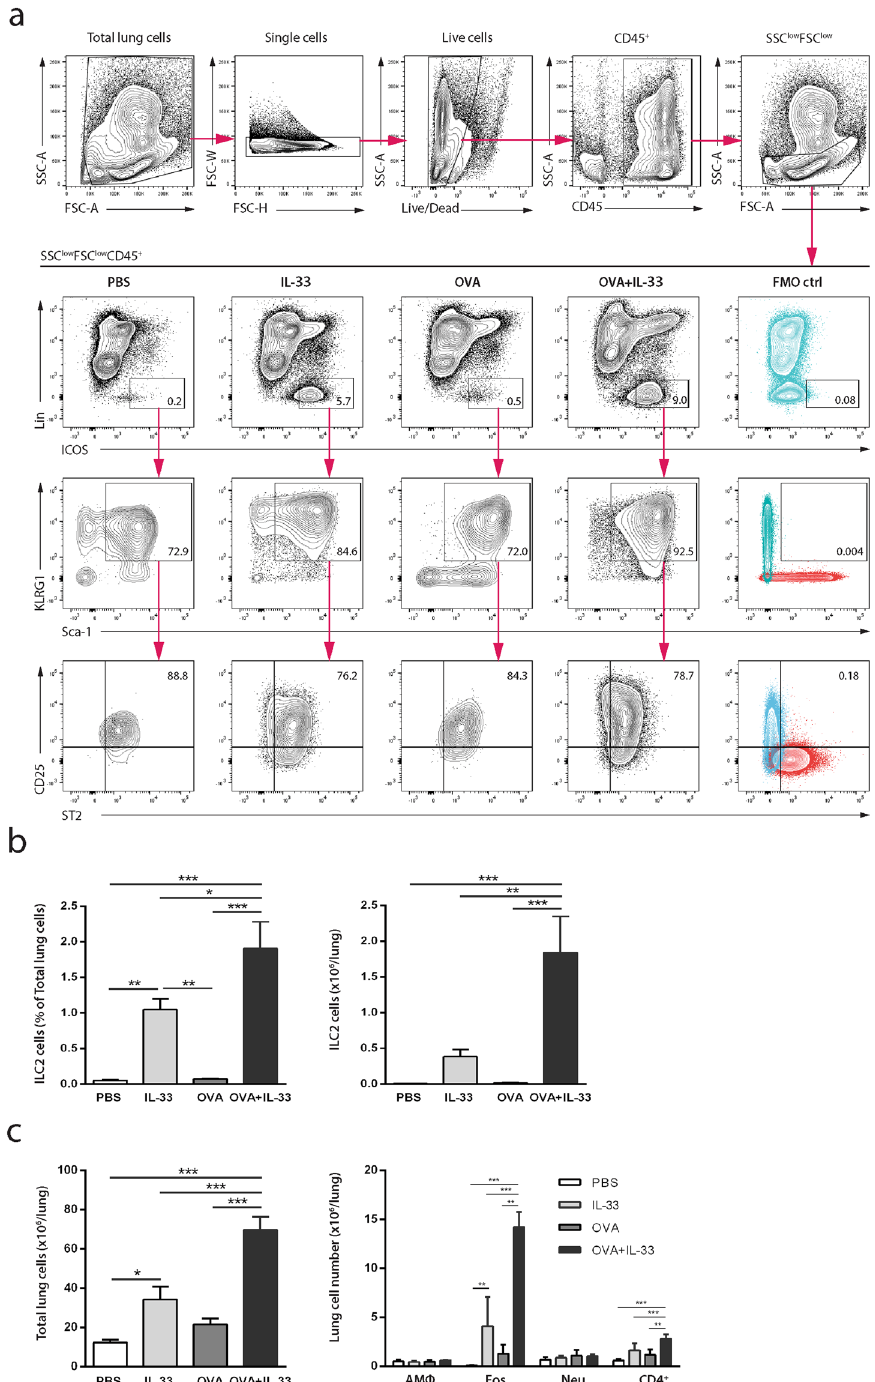
Figure 5. IL-33 enhances the accumulation of pulmonary ILC2s in OVA-sensitized mice. Flow cytometric analysis of lung cells. ( a ) ILC2s were identified as SSC low FSC low CD45 + Lin − ICOS + KLRG1 + Sca-1 + CD25 + ST2 + cells. Gates were set based on FMO controls, FMO ctrl = overlay of the two FMO controls for each respective plot. The representative FMO plots and plots showing the representative SSC low FSC low CD45 + gating belong to the OVA + IL-33 group. ( b ) Frequency and numbers of pulmonary ILC2s. ( c ) Quantification of inflammatory lung cells. Alveolar macrophages were identified as CD45 + SiglecF + CD11c + , eosinophils as CD45 + SiglecF + CD11c − CD11b + Gr-1 lo , neutrophils as CD45 + SiglecF − CD11c − Gr-1 hi CD11b hi and CD4 + cells as CD45 + CD11b − CD4 + (frequency and representative plots including FMO controls can be found in Supplementary Fig. S1). * p < 0.05, ** p < 0.01, *** p < 0.001 (ANOVA, Bonferroni). Results are pooled data of four independent experiments (mean ± SEM of n = 8 mice in each